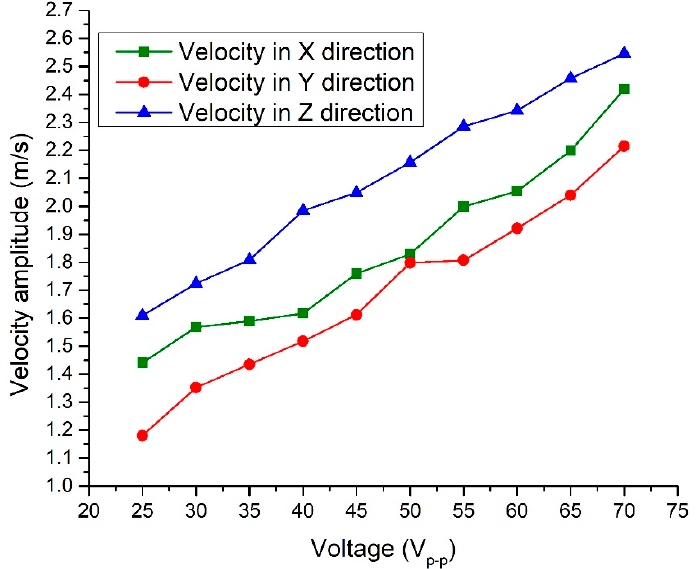
Figure 13. Velocity amplitude of the contact point in the XYZ directions versus driving voltage.